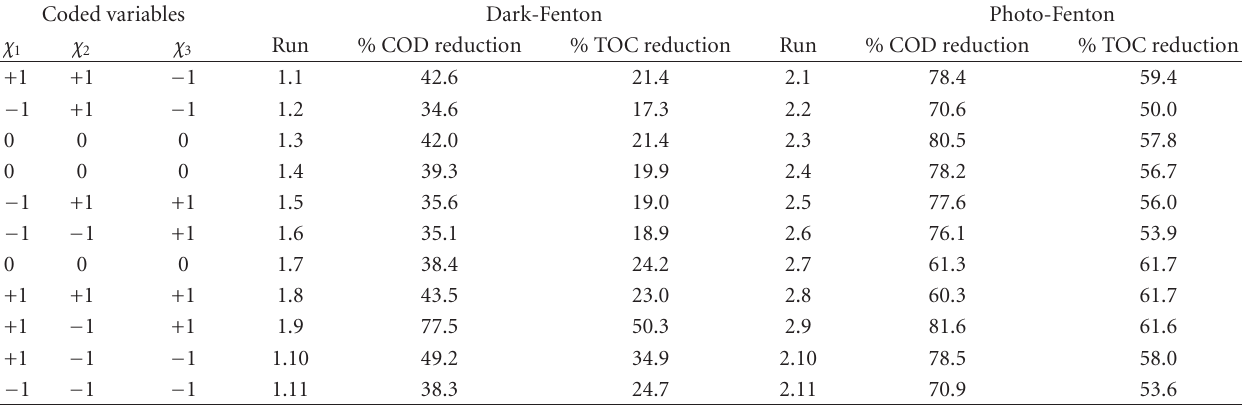
Table 4: COD and TOC reductions (%) with dark-Fenton and photo-Fenton experiments. Coded